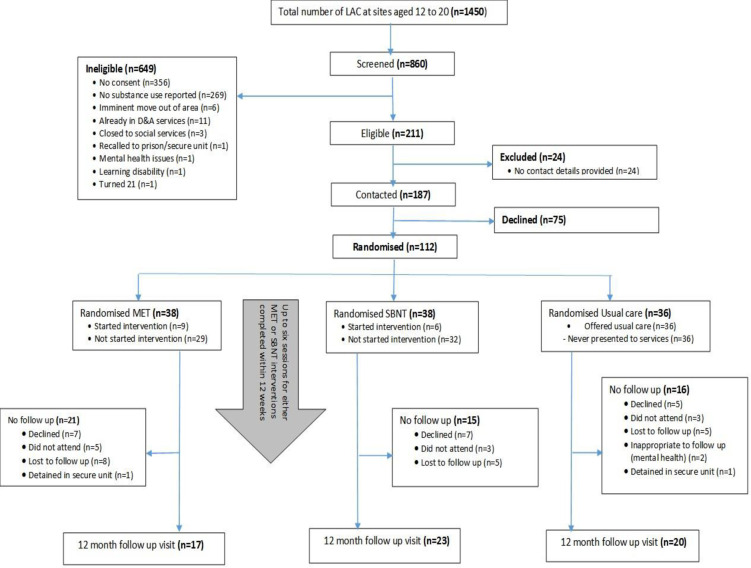
Consort diagram.